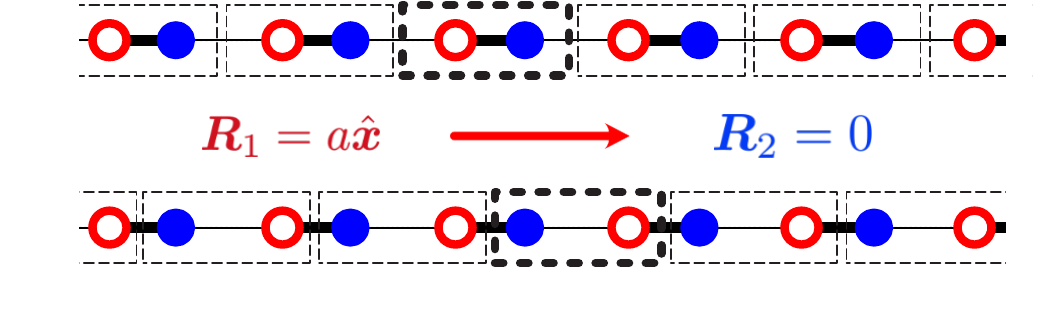
Figure 10: Unit cell transformation. We illustrate the definition of the R α vectors using the simple example of a SSH chain. For the first atom (empty symbol) R = 0 for the second atom (solid while R 2